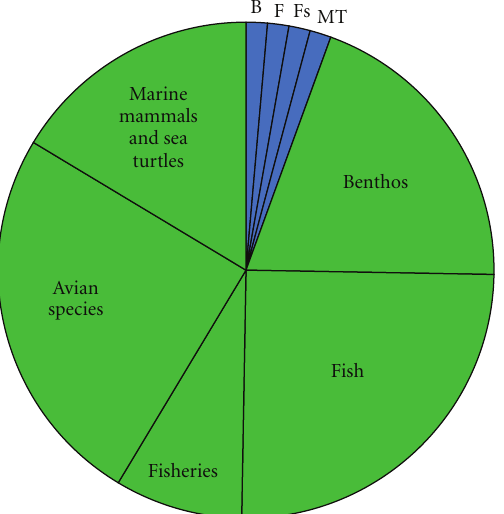
Figure 2: Pie chart representing the proportion of impacts for each ecosystem component for Impact scenario i1, demonstration-scale projects, categorized by whether the e ff ect is positive (blue), minor negative (green), moderate negative (yellow), or major negative (red). B = Benthic habitat and resources; F = Fish; Fs = Fisheries; A = Avian species; MT = Marine mammals and sea